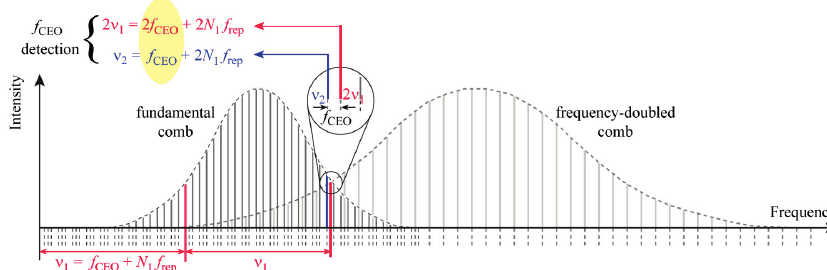
Figure 2. Principle of the f -to-2 f interferometry method used to generate the CEO beat from an octave-spanning comb spectrum. A red component of the comb spectrum at is frequency-doubled and heterodyned with a blue component at (cid:2021) = (cid:1858) + (cid:1840) · (cid:1858) (cid:2869) (cid:2887)(cid:2889)(cid:2899) (cid:2869) (cid:2928)(cid:2915)(cid:2926) to produce a beat at frequency f CEO . In practice, the CEO (cid:2021) = (cid:1858) + 2(cid:1840) · (cid:1858) (cid:2870) (cid:2887)(cid:2889)(cid:2899) (cid:2869) (cid:2928)(cid:2915)(cid:2926)